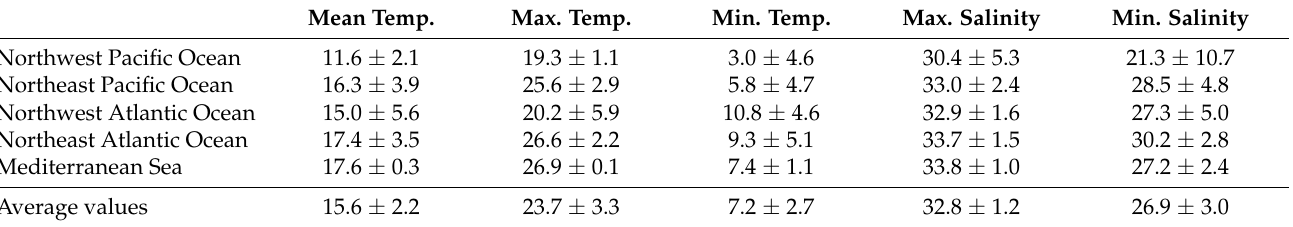
Table 1. Summary of the environmental descriptors including minimum, maximum and mean temperature ( ◦ C), and maximum and minimum salinity (‰), of the biogeographical regions of Gracilaria vermiculophylla . Mean Temp. Max. Temp. Min. Temp. Max. Salinity Min.